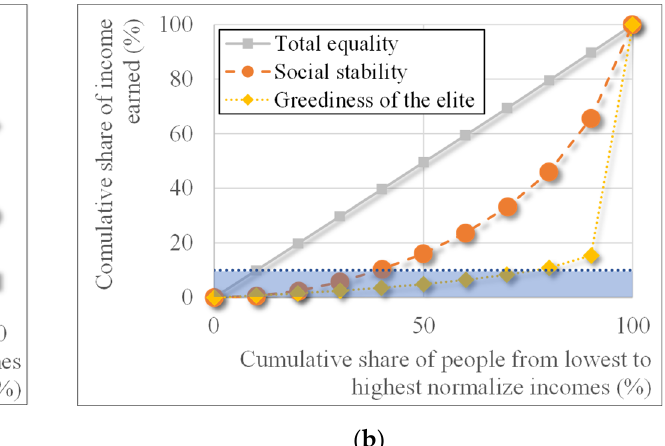
Figure 8. Different types of distribution of wealth. Gray rectangles show total equality with Gini coefficient equal to 0; orange circles show exponential distribution with Gini coefficient equal to 0.5; yellow diamonds show power-type Pareto distribution (greediness of elite) with Gini coefficient equal to 0.7 ( a ) Share of wealth ( b ) Lorenz curve (blue area represents a recession 10%).